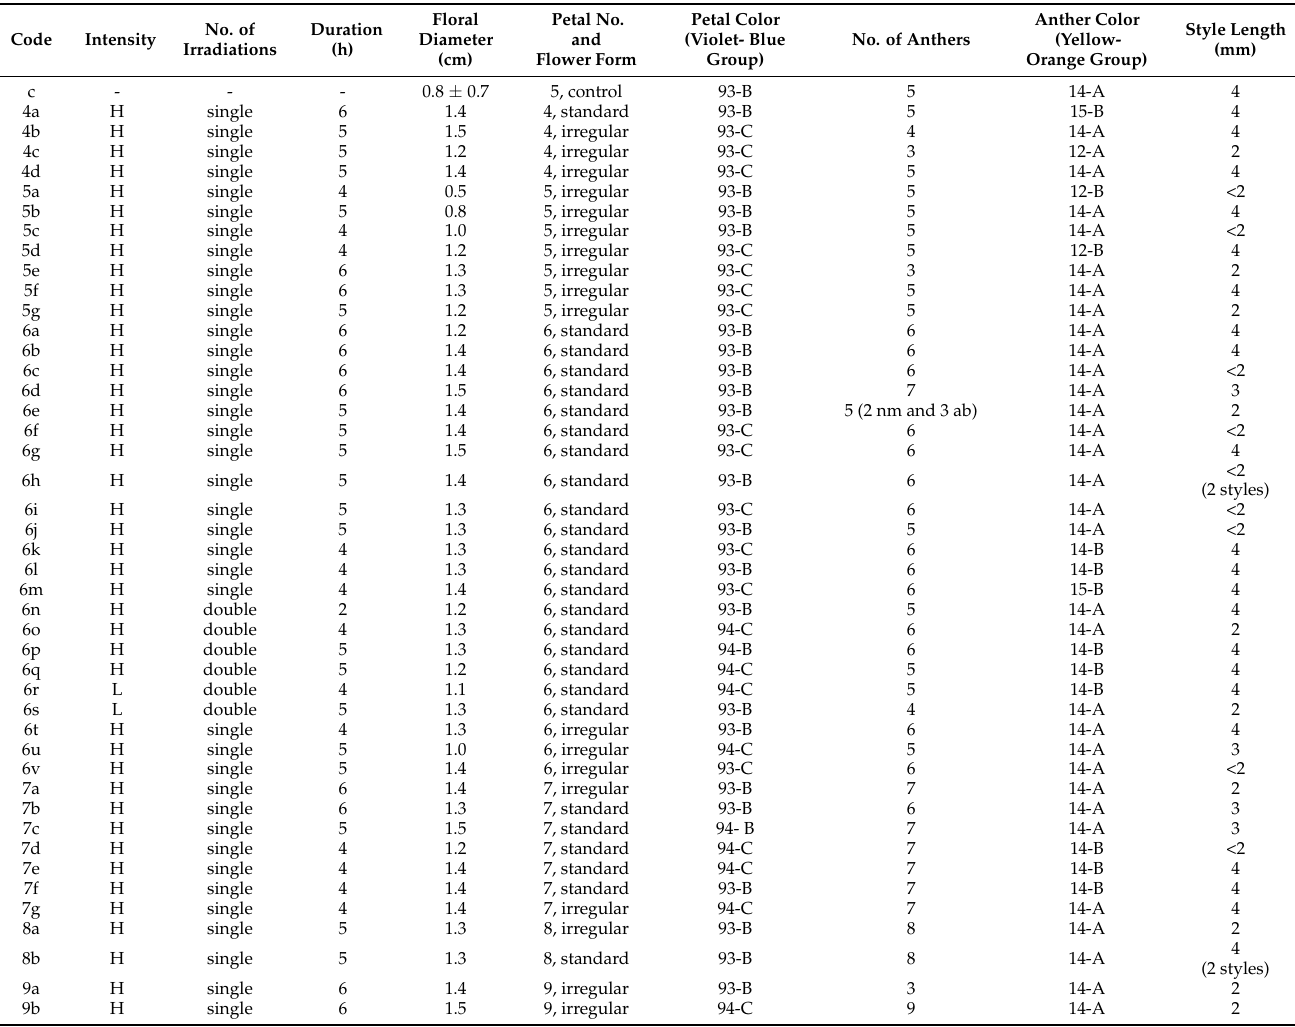
Table 2. Characteristics of 44 mutated flowers of Persian violet after irradiation with low (L)- and high (H)-intensity UV-C for single or double application for various